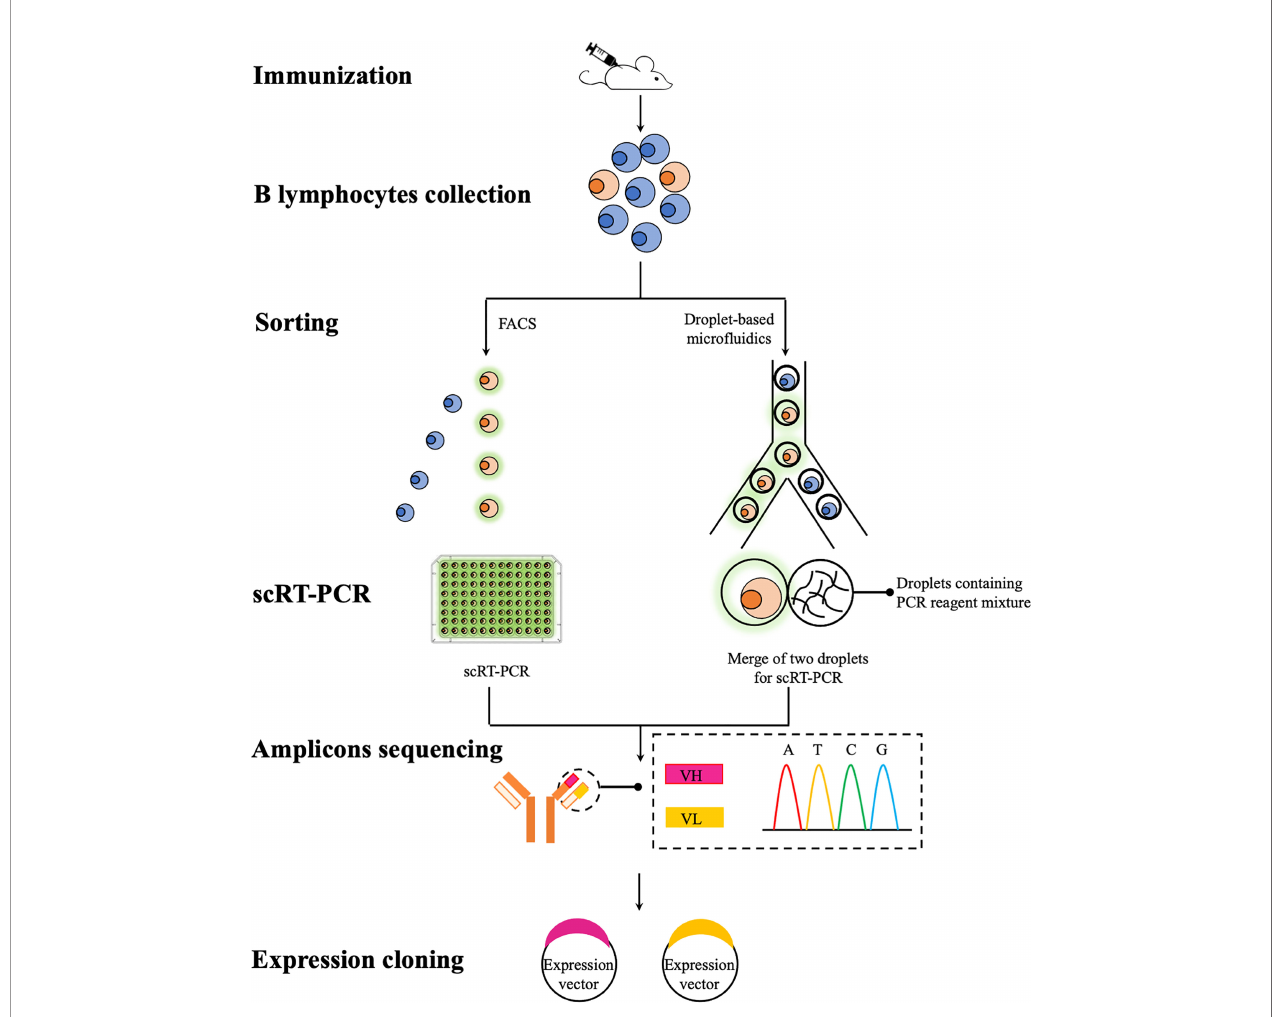
FIGURE 1 | A schematic overview of recombinant mAbs production using FACS and droplet-based micro fl uidics. B lymphocytes (e.g. splenocytes and plasmablasts) are collected from immunized mice and then individually sorted via FACS or droplet-based micro fl uidics for antigen-speci fi c lymphocytes. Paired VH and VL sequences are then ampli fi ed using scRT-PCR for subsequent sequencing (e.g. traditional Sanger sequencing and next-generation sequencing if bar-coded primers used during the scRT-PCR step) and subcloning. Expression vectors containing VH and VL sequences can be co-transfected into a range of expression systems for the production of recombinant